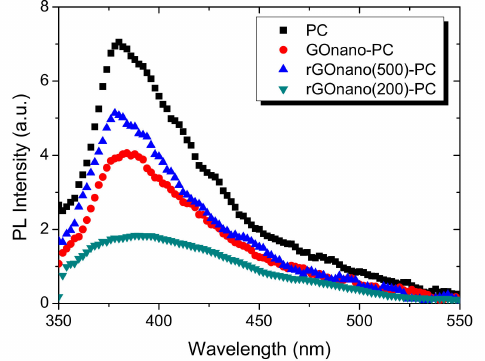
Figure 8. Photoluminescence (PL) spectra of the pristine, GO-functionalized and rGO-functionalized photonic